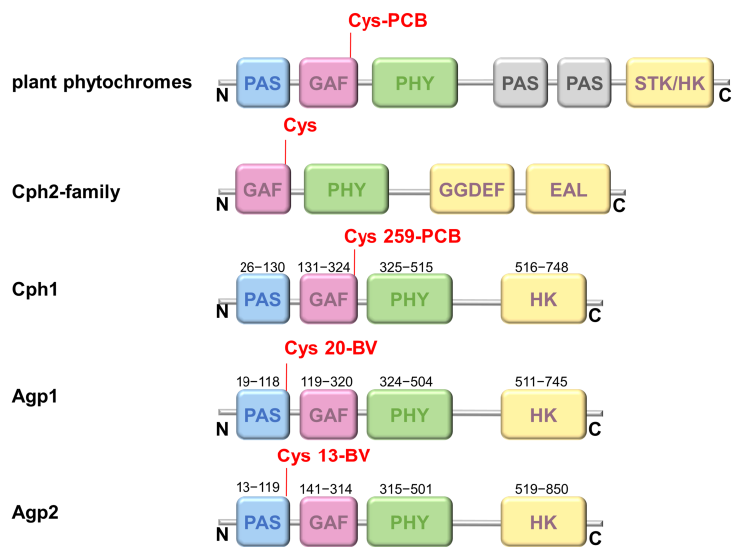
Figure 1. Protein domains in different phytochromes. The different photosensory domains PAS (blue), GAF (magenta), PHY (green), and the output domain (histidine kinase (HK) or similar (STK-HK: HK related domain; GGDEF-EAL: c-di-GMP turnover domain) (yellow) are shown according to the N- to C-terminal phytochrome sequence. Almost all phytochromes hold only a single chromophore-binding site at a conserved cysteine residue either at the PAS domain in the case of Agp1 and Agp2 or GAF domain in the case of plant phytochromes, Cph1, and Cph2.